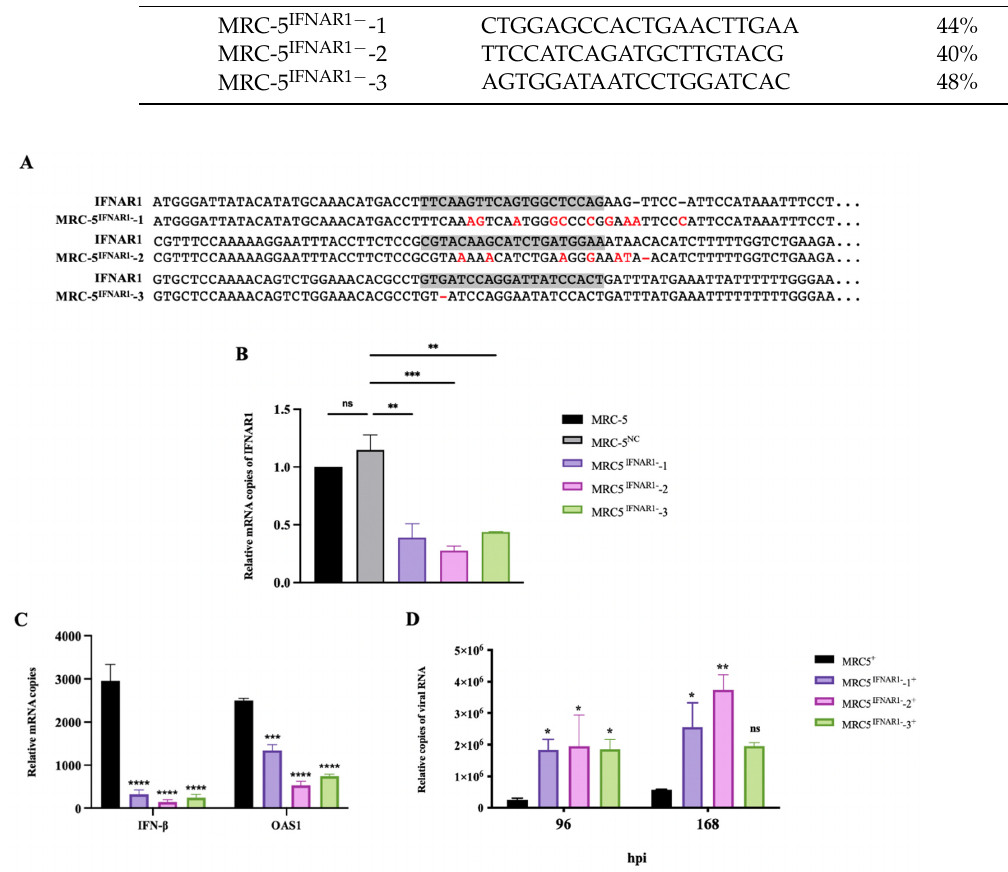
Table 4. Sequences of IFNAR1 guidance RNA (gRNA) and evaluation of gRNA cleavage efficiency.